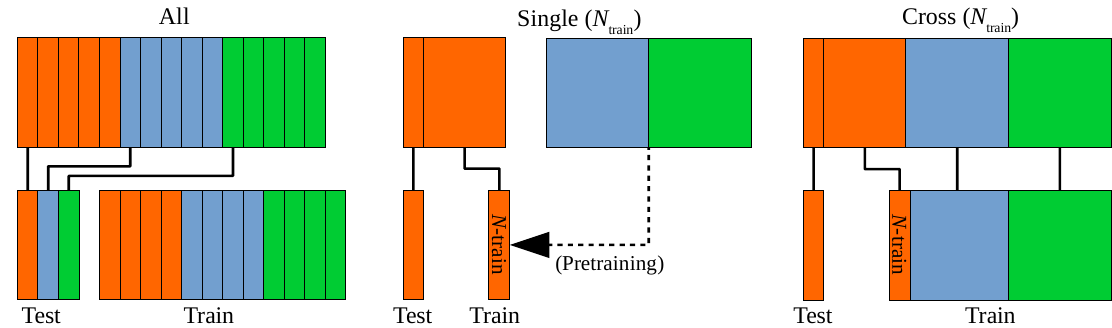
Figure 10. Scheme of the used cross fold training. Each color represents a part that is split into a five fold (smaller boxes). Depending on the experiment different sections are chosen for training and testing. Optionally, a pretrained model on remaining data is used. For the cross-part scheme N train can be set to zero to only train on other